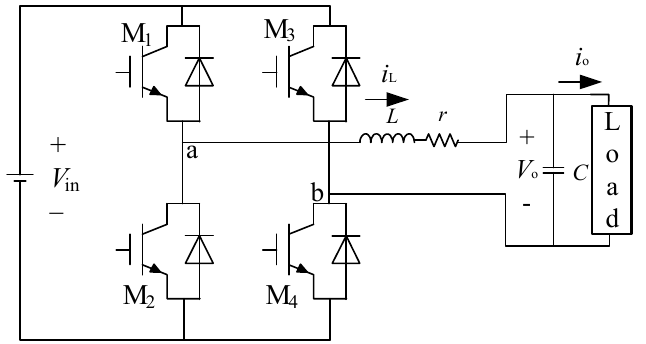
Figure 1. The topology of single-phase H-bridge converter.